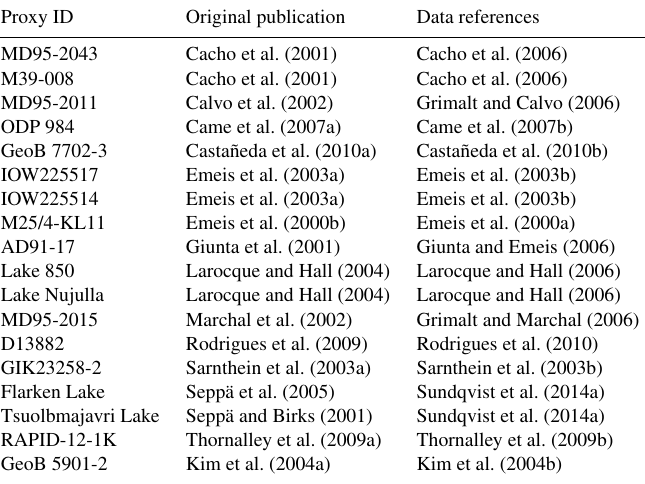
Table A1. Additional information for the used proxy records: proxy ID, main reference, and reference for the datasets. For additional information, see Table 1.